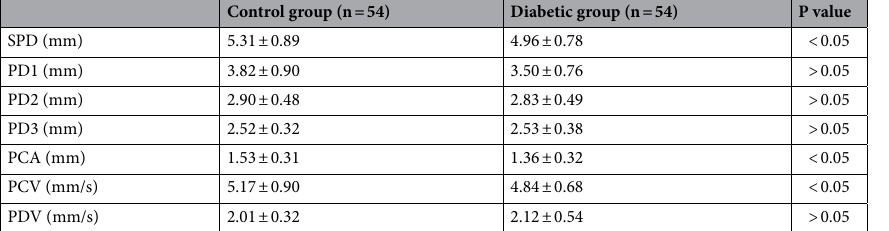
Table 2. Results of pupillometry for the patients by group after PSM. SPD scotopic pupil diameter, PD1 pupil diameter at light intensity of 1 cd/m 2 , PD2 pupil diameter at light intensity of 10 cd/ m 2 , PD3 pupil diameter at light intensity of 100 cd/m 2